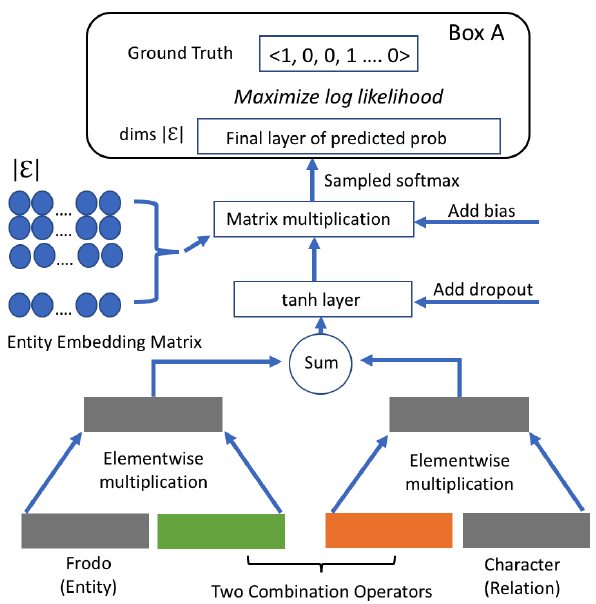
Figure 3. Base ProjE softmax architecture for